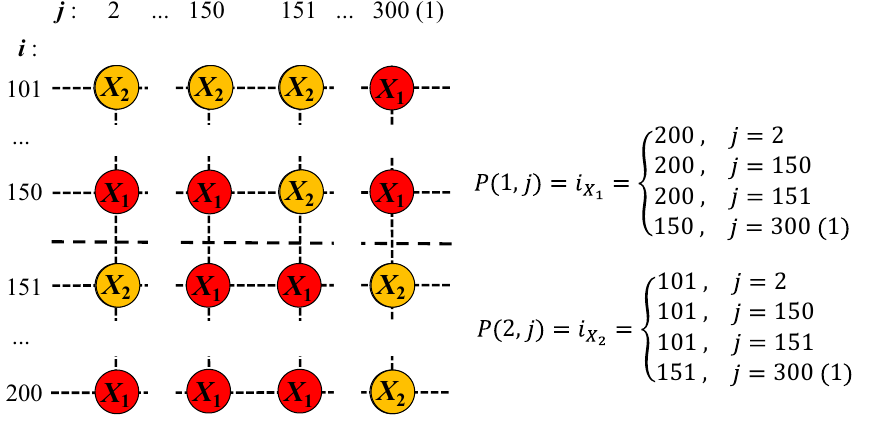
Figure 5. Diagram of the definition and numerical determination of P (1, j ) and P (2, j ). In accordance with the definition in Fig. 1a, species are distributed in two different fields on the network. Here, X 1 ( X 2 , X ∈ A , B , C ) is used to represent individual species initially distributed in the upper (lower) half of the territory, and colored nodes respectively represent their distribution positions in the lattice network. Each node in the network is given a position coordinate, defined by its row, column number i and j . In the diagram, for each column j , we can see two scenarios: the species remaining in its territory (when j = 300 ( 1 ) , with (1) represents periodic boundary), and the species invading rival territory (when j = 2, 150, 151 ). In accordance with the descriptive definition of P ( 1, j ) ( P ( 2, j )) in formula (5), we take the position of X 1 ( X 2 ) closest to the two neighborhood interfaces as the value of P ( 1, j ) ( P ( 2, j )) for the first case, while for the second case, we take the farthest point in the opponent’s domain where X 1 ( X 2 ) can invade as the value of P ( 1, j ) ( P ( 2, j )) . The right hand side of the diagram shows the corresponding